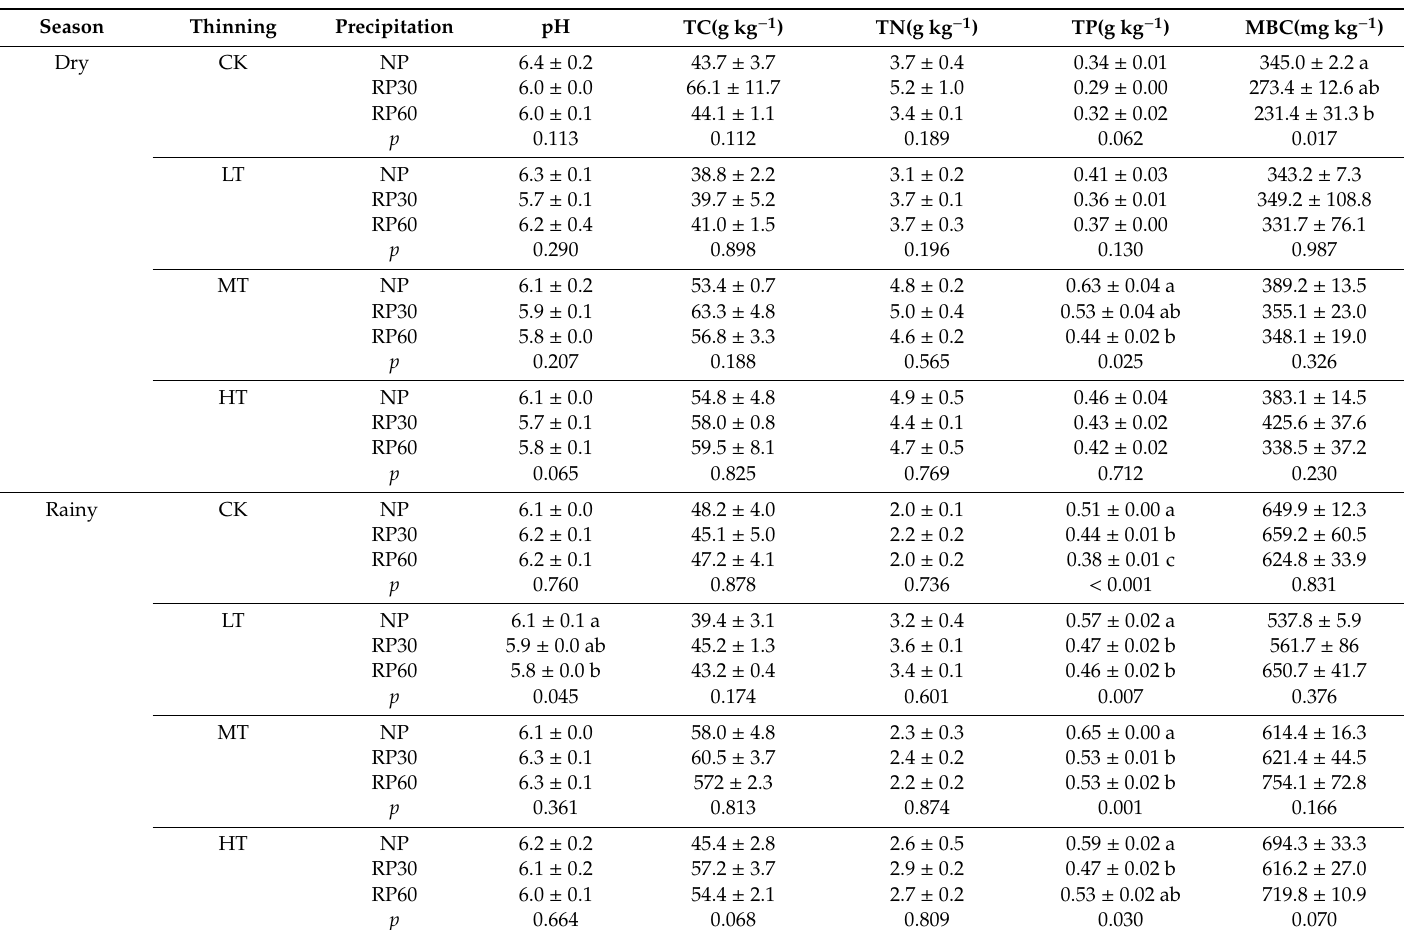
Table 1. Soil properties in the dry and rainy seasons and their responses to the various precipitation and thinning treatments in L. principis - rupprechtii